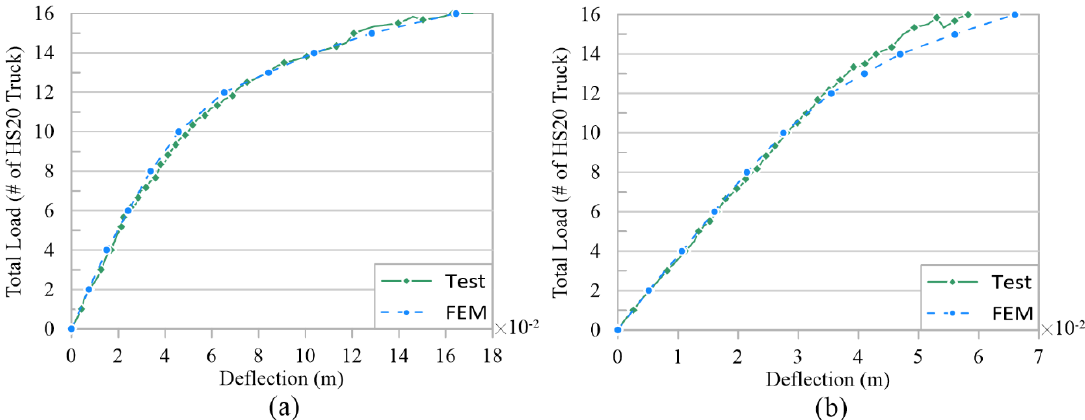
Figure 4. Finite element validation using load- deflection curves obtained from the test. ( a ) Interior Girder and ( b ) Exterior Girder.